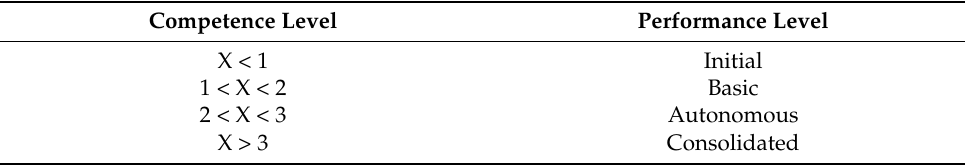
Table 3. Competence and Performance Levels of Research Professors.